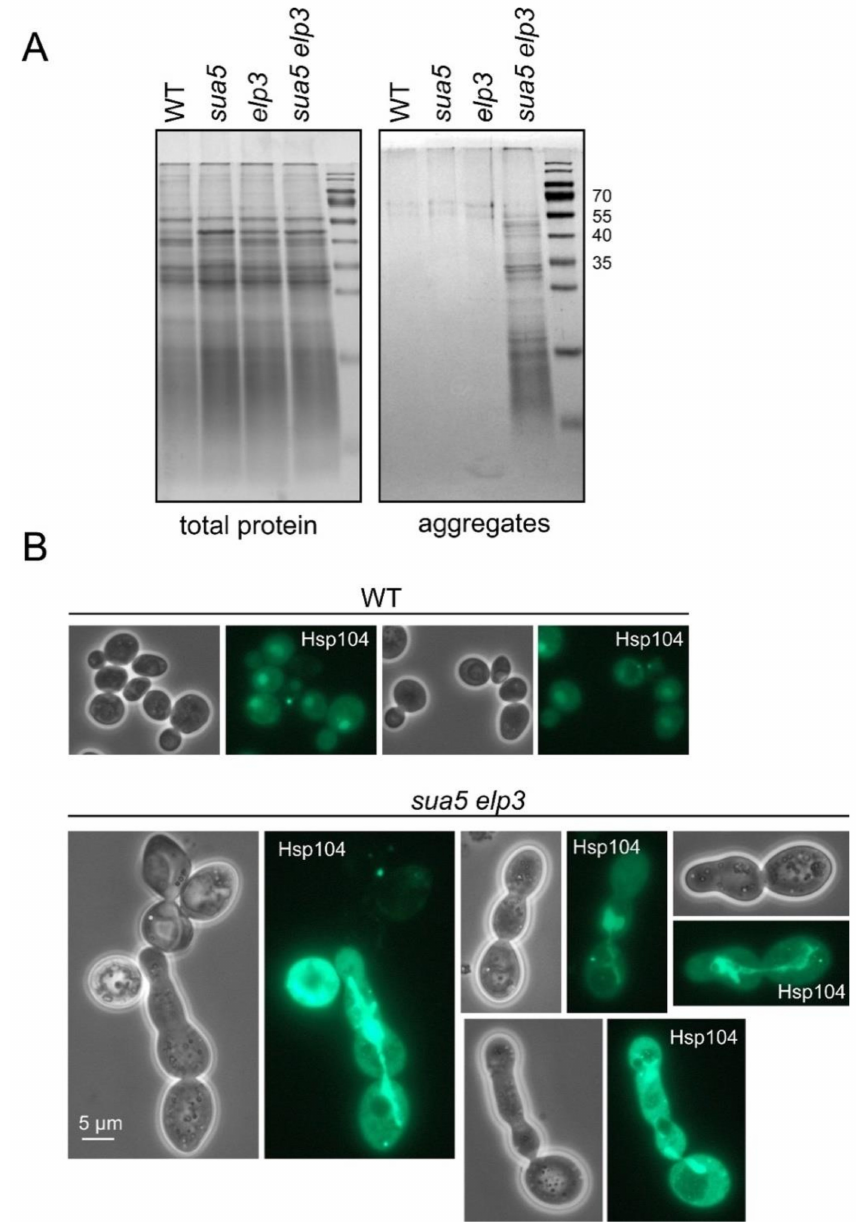
Figure 4. Aggregate formation in the sua5 elp3 double mutant. ( A ) Protein extracts of indicated strains were generated and analyzed by SDS PAGE before (total protein) and after enrichment of aggregates, as described previously [4,29]. Aggregates were isolated twice from each strain. Note that the method used for the solubilization of aggregated proteins used here is not as harsh as that used for the [ 35 S] labeling and proteomics analyses (Figure S3). ( B ) Expression Hsp104-GFP from its natural genomic locus in WT and sua5 elp3 backgrounds. The HSP104-GFP allele was introduced into sua5 elp3 by crossing and tetrad